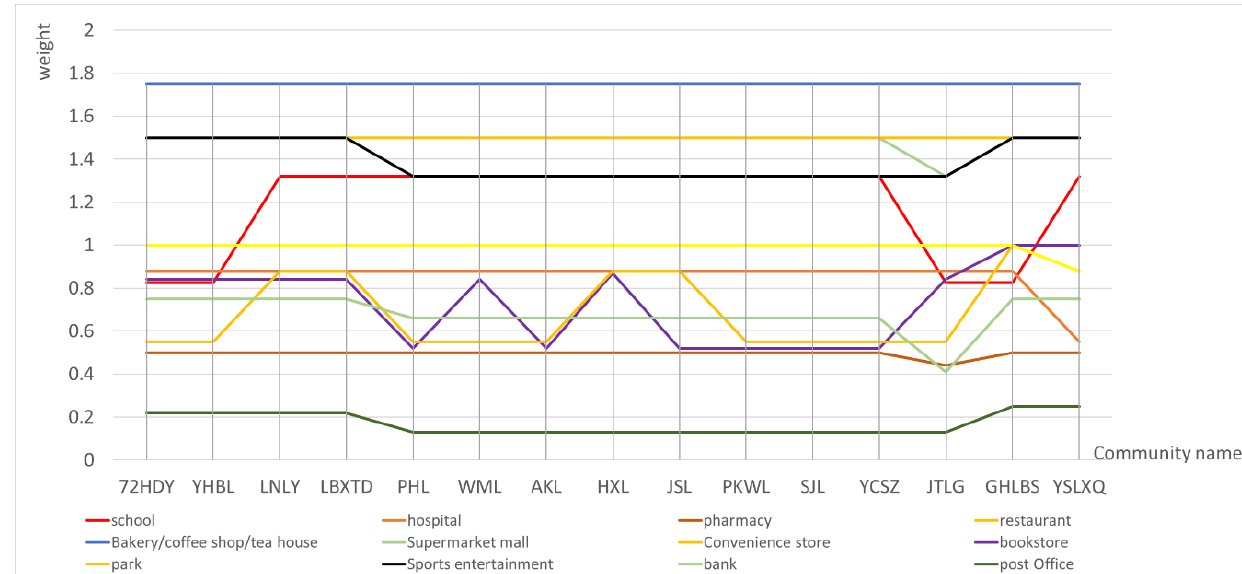
Figure 4. Community with low street walking index.